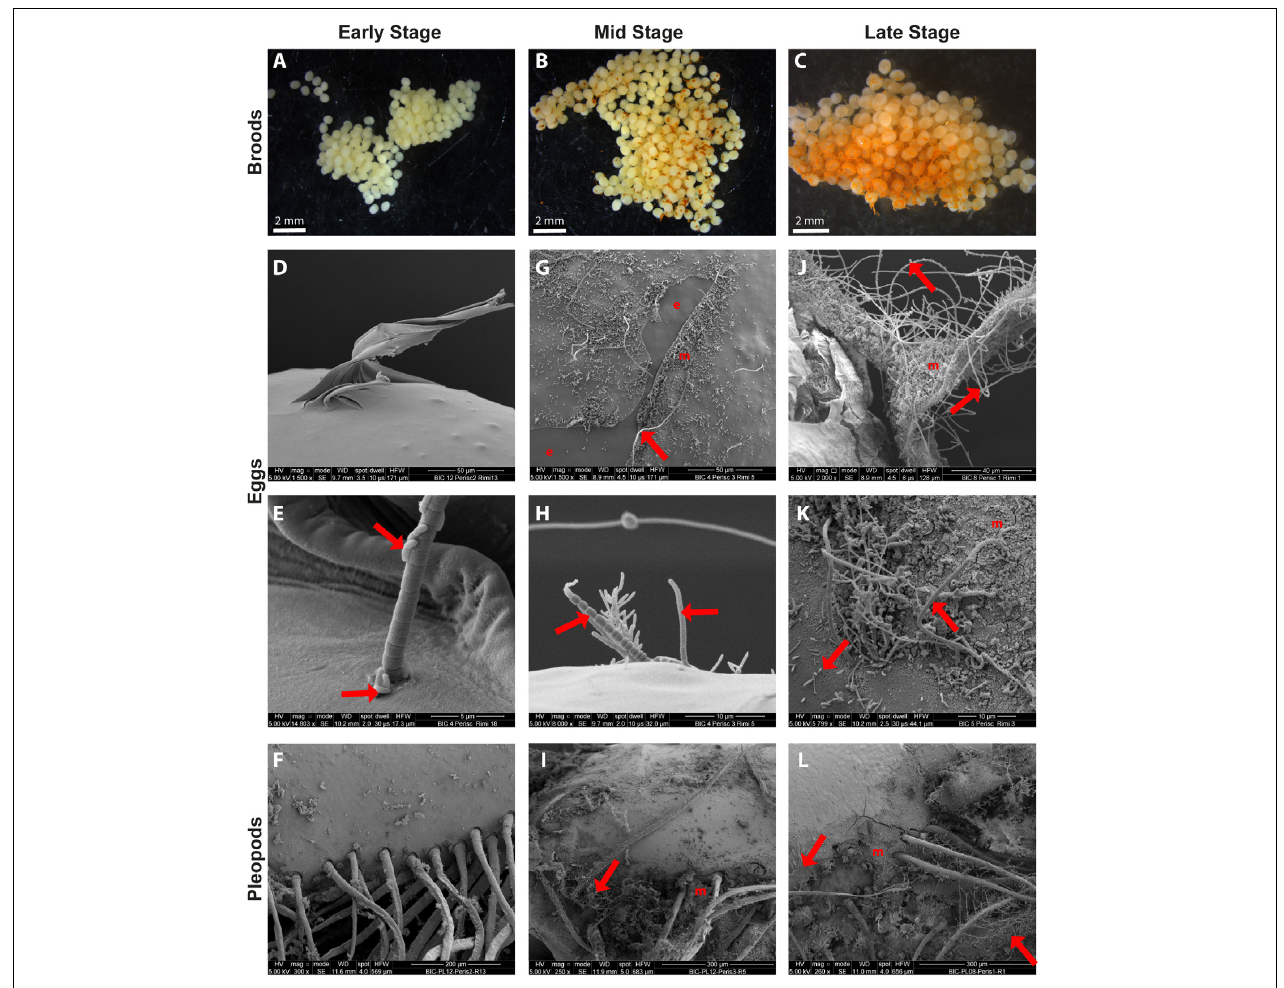
FIGURE 2 | SEM observations of epibiotic bacteria on the surface of R. exoculata eggs and pleopods. Rimicaris exoculata egg broods observed under a stereomicroscope with eggs at (A) early stage, (B) mid stage, (C) and late stage. Individual eggs observed under a scanning electron microscope with eggs at (D,E) early stage, (G,H) mid stage (J,K) and late stage. Pleopods observed under a scanning electron microscope holding broods at (F) early stage, (I) mid stage, (L) and late stage. The crusts observed in the close-ups both on eggs (K) and pleopods (L) in SEM are deposits of ferric oxide, which correspond to the orange coloration observed under stereomicroscope on egg broods (B,C) . Red arrows are targeting some of the rod shaped and filamentous bacteria observed in these pictures. e, bare egg envelope areas where mucus layer have been removed and m, egg envelope areas covered by mineral